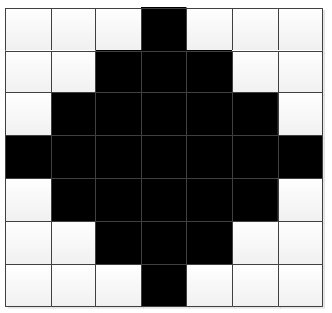
Figure 2. The structuring elements used in the closing operation.